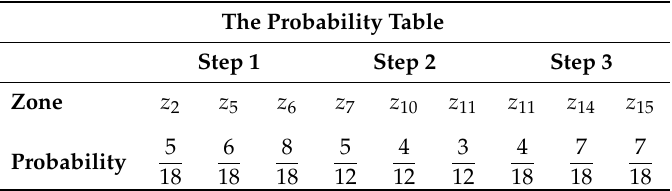
Figure 6. The examples of selecting next zone: ( a ) Step 1 ( C = { z 1 , z 5 , z 6 }); ( b ) Step 2 ( C = { z 7 , z 10 , z 11 } ); ( c ) Step 3 ( C = { z 11 , z 14 , z 15 } ); and ( d ) a path moved to the destination zone. Table 3. The probabilities of selecting next zones in Figure